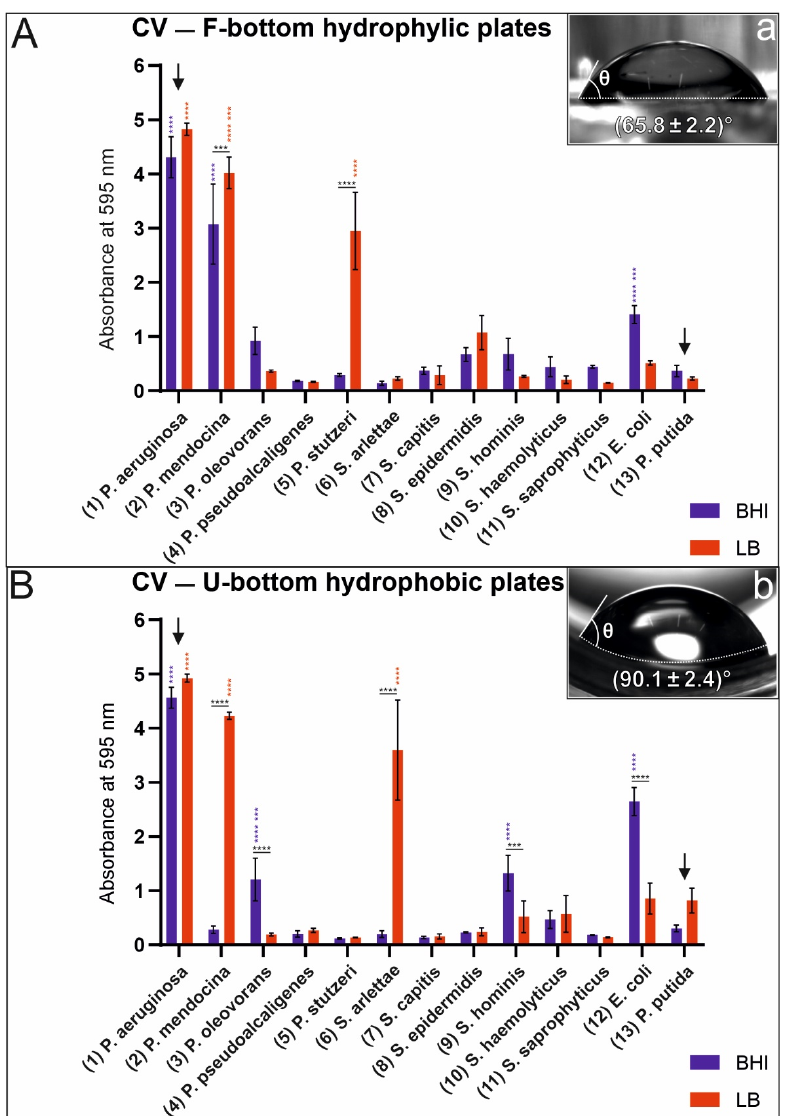
Figure 1. Crystal violet staining of monoculture biofilms using hydrophilic F-bottom ( A ) and hydrophobic U-bottom ( B ) polystyrene plates. Strongest biofilm producers are P. aeruginosa (see left arrow) and P. mendocina . Goniometer measurements for validation of hydrophilic/hydrophobic surface features of an F-bottom plate with a contact angle of 64.8 ± 2.2° ( A ) and of a U-bottom plate with a contact angle of 90.1 ± 2.4° ( B ). For statistical analysis, a two-way ANOVA or a mixed-effects analysis was performed. Only high-significance values are shown (0.0002 (***), <0.0001 (****)). Black stars in the horizontal direction show the significance values between the media used for cultivation for one bacterial strain. Blue and red stars in the vertical direction indicate the significance values for the BHI medium (blue) and the LB medium (red) based on one bacterial strain compared to all other bacterial strains. Hydrophilic F-bottom plates ( A ): The absorbance values of P. aeruginosa and P. mendocina cultured in the LB and BHI media are significantly higher than those of every other bacteria. Values of P. stutzeri cultured in the LB are significantly higher than those of every other bacteria in respect to P. aeruginosa and P. mendocina . E. coli cultured in the BHI reveals significantly higher absorbance values against all other bacteria in respect to P. aeruginosa and P. mendocina . Hydrophobic U-bottom plates ( B ): P. aeruginosa cultured in the LB and BHI, P. mendocina and S. arlettae cultured in the LB reveal significantly higher absorbance values than all other bacteria. The absorbance values of E. coli , S. hominis and P. oleovorans cultured in the BHI are significantly higher than those of all other bacteria in respect to P. aeruginosa. P. putida , which was described as a strong biofilm producer in previous studies, shows low biofilm formation in these assays (see right